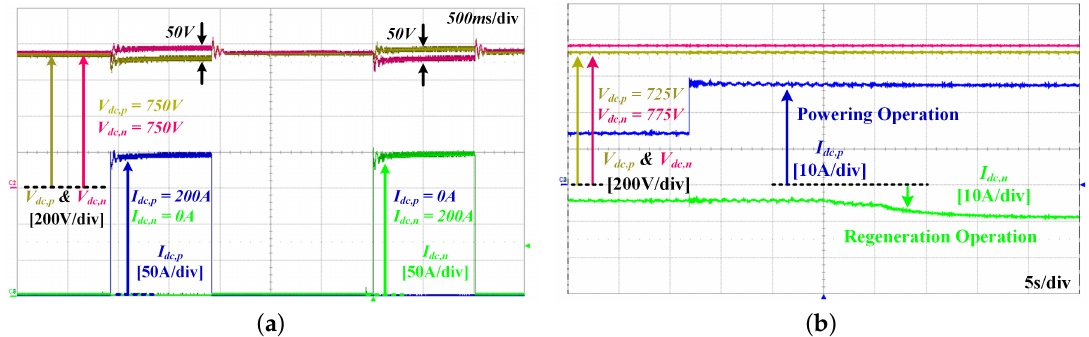
Figure 17. Experimental results of the balancing operation of DC/DC converter: ( a ) Extremely heavy asymmetric load conditions; ( b ) Bi-directional unbalancing condition.